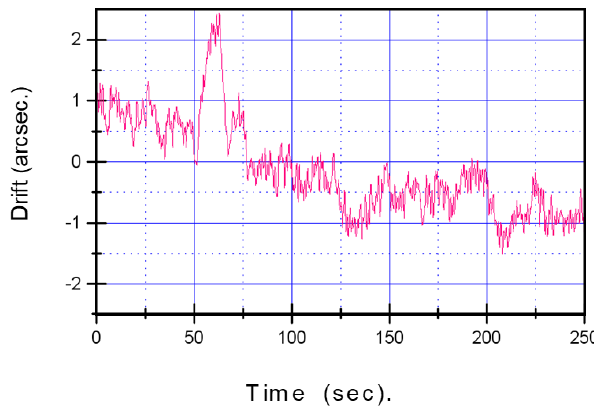
Figure 5. Drift of the star image center along X on a windy night.